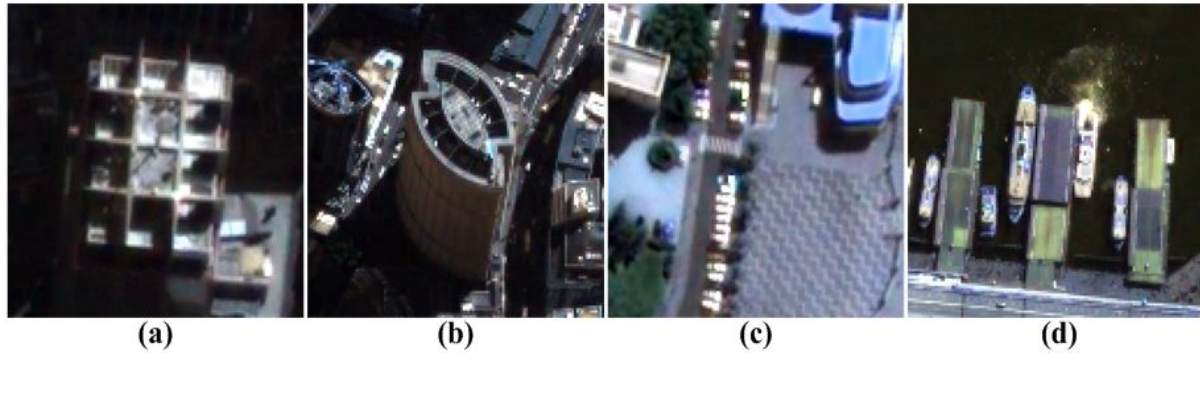
Figure 11. Four real UAV test